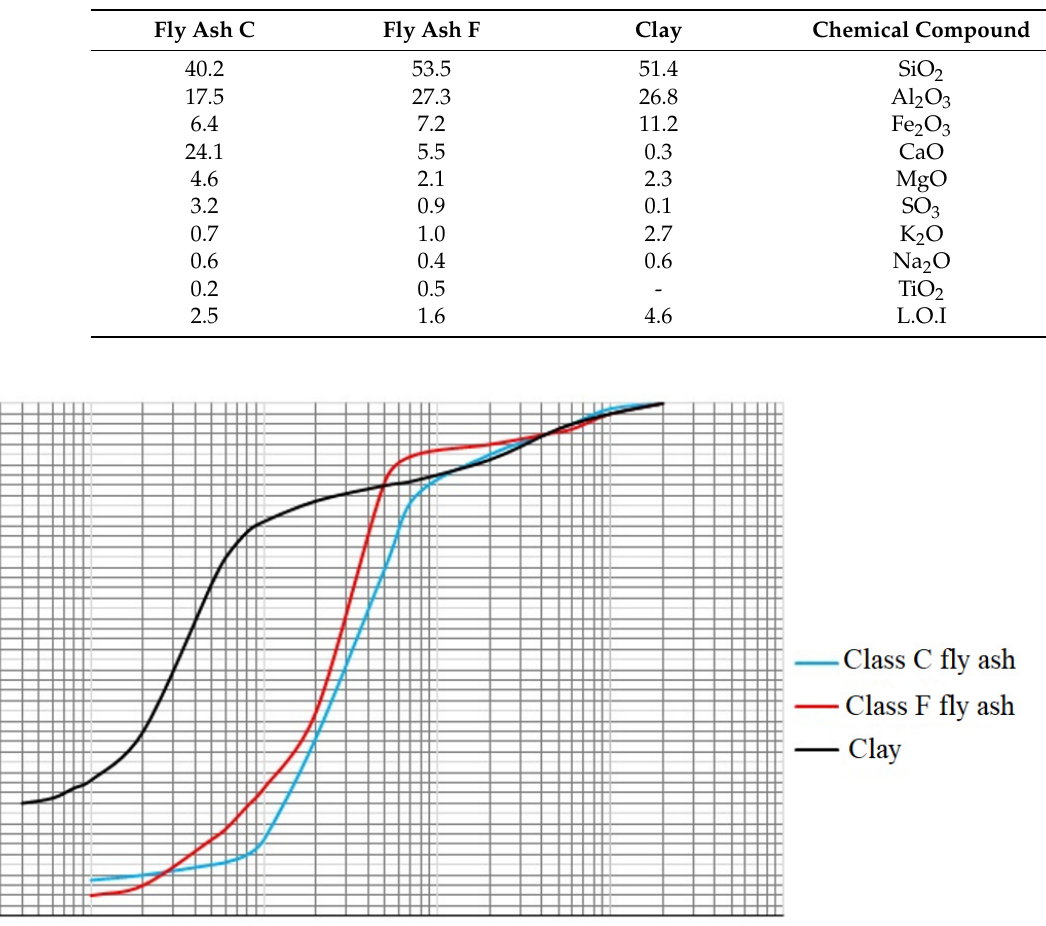
Table 2. Chemical composition of materials used.